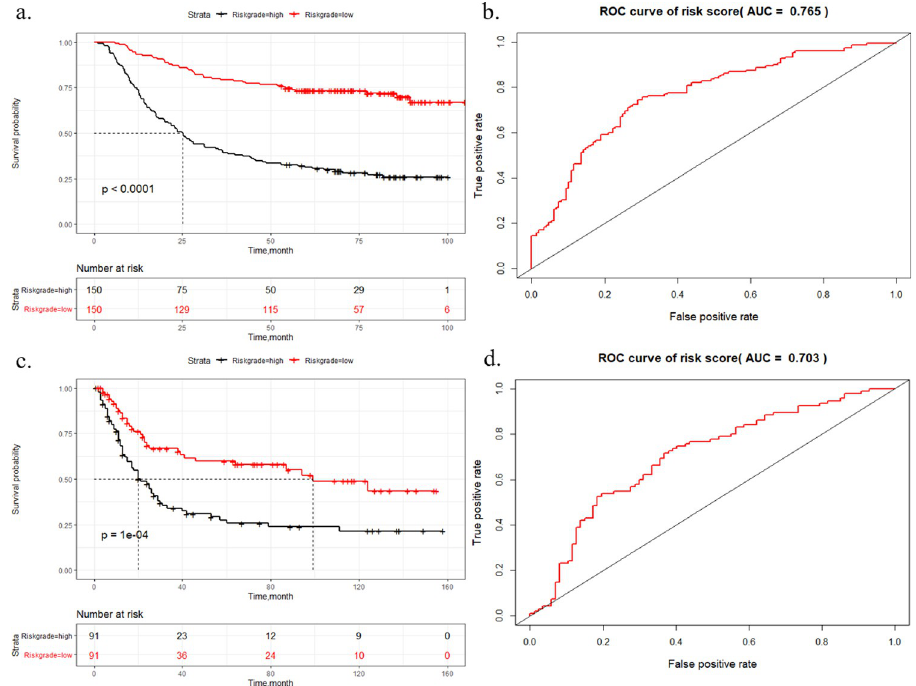
Fig 4. a) Kaplan-Meier curve of GSE66229 survival data for high-risk and low-risk groups with p < 0.0001. b) The ROC curve of the risk score for predicting survival in the GSE66229 dataset. c) Kaplan-Meier curve of GSE15459 survival data for high-risk and low-risk groups with p = 0.0001. d) The ROC curve of the risk score for predicting survival in the GSE15459 dataset.